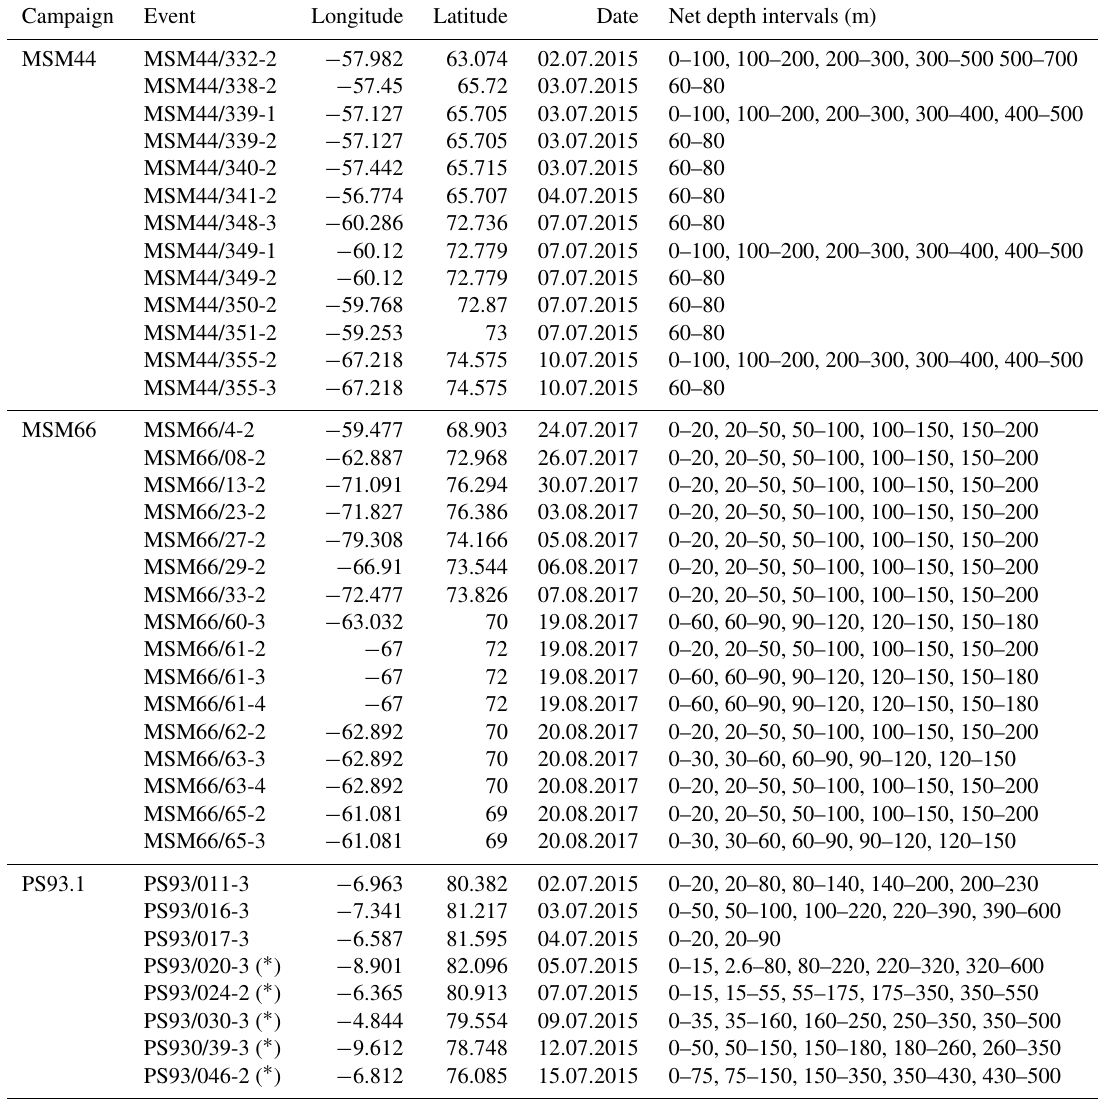
Table 3. Overview of the sampled depth intervals from the stations of MSM44, MSM66 and PS93.1. Abundances of N. pachyderma of profiles marked with ( ∗ ) are also published in Greco et al. (2021b), but counts presented in the studies were done independently from that